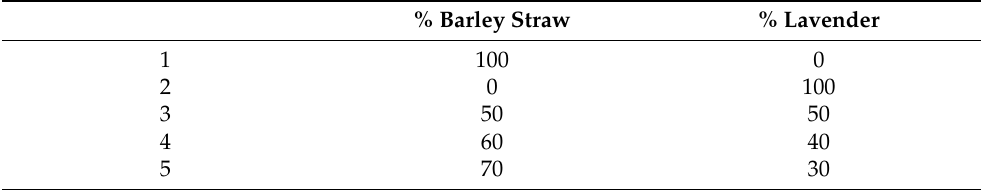
Table 1. Details of the different percentages of lavender present in the